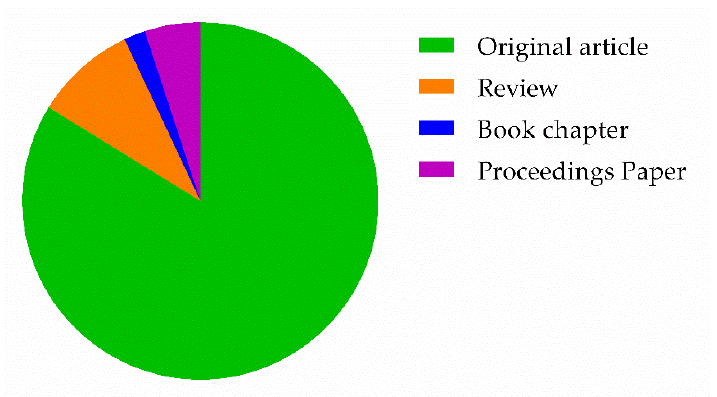
Figure 2. Graphical distribution of the research products. Among the 654 documents, 563 were original articles, 62 were review manuscripts, 13 were book chapters, and 34 were proceedings or conference papers.